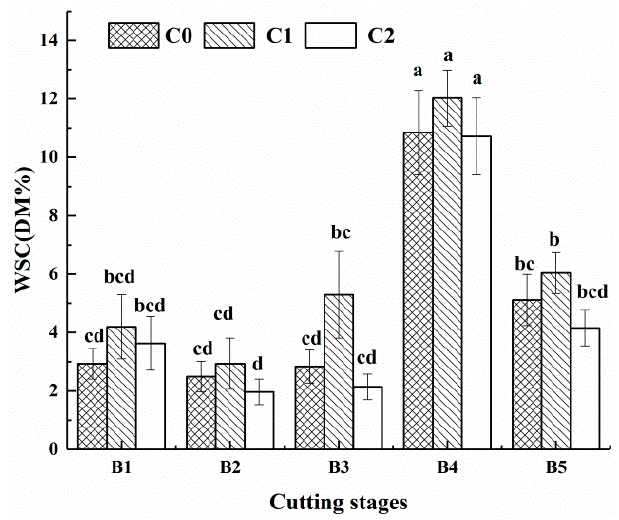
Figure 3. Differences in the average WSC content for the interaction between cutting stage and lactic acid bacteria additives. Different letters mean significantly differences at p < 0.05. WSC: water-soluble carbohydrate; B1: heading stage; B2: flowering stage; B3: grouting stage; B4: milky stage; B5: dough